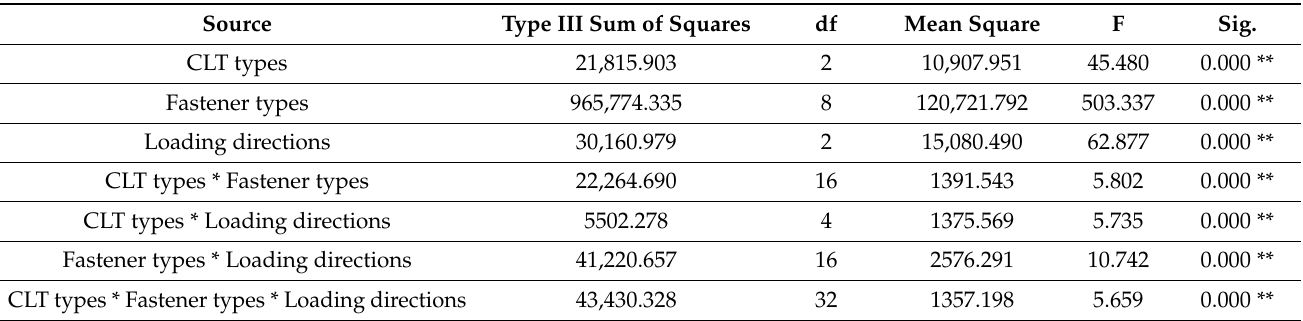
Table 3. Analysis of variance’s main and interaction effects of the layer arrangement, fastener type, loading direction on the withdrawal resistance of